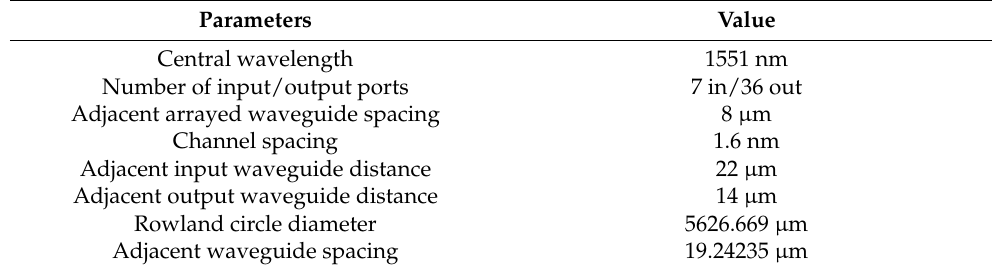
Table 1. AWG design key parameters.